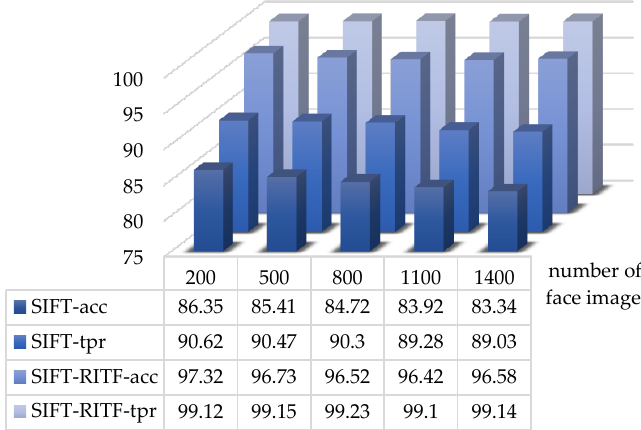
Figure 14. Comparison between SIFT and SIFT/RITF models (LFW face